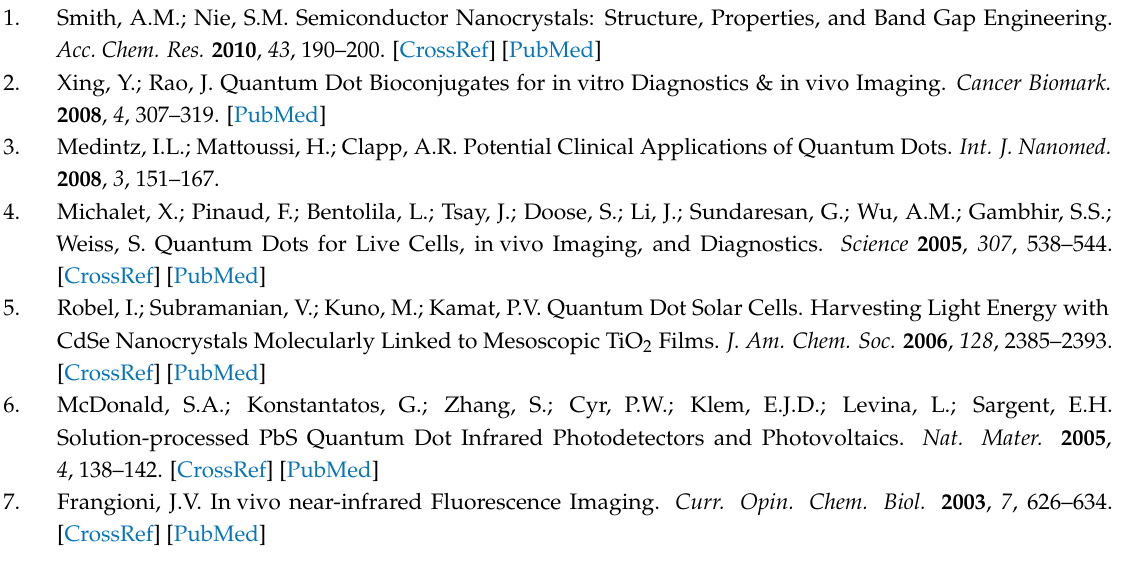
Figure S1: Images of the QDs under ambient light and UV light. Figure S2: EDS spectra of the CdTeSe QDs at different molar ratios of Te:Se (1:0, 0.75:0.25, 0.50:0.50) and time reaction of 60 min. Figure S3: Experimental values for the donor relative PL intensity decay (red line) and acceptor PL intensity gain (blue line) versus molar ratio [Cy5]/[QD]. Table S1: Optical characterization of the CdTeSe QDs. FRET calculations and Equations